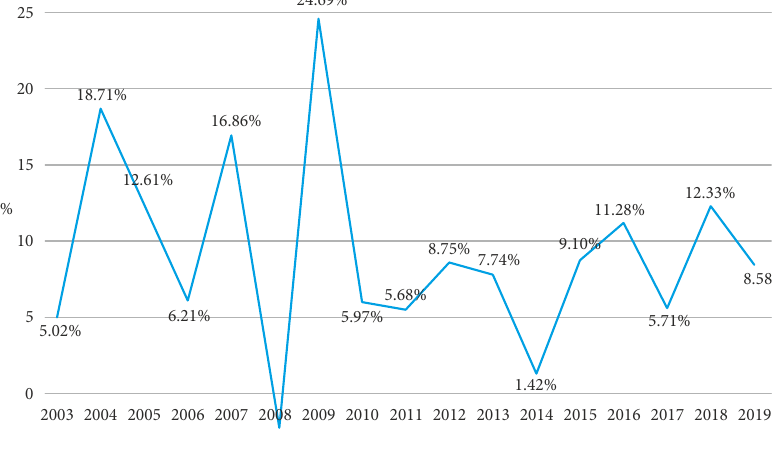
Figure 1. Residential property price growth (National Bureau of Statistics of China,